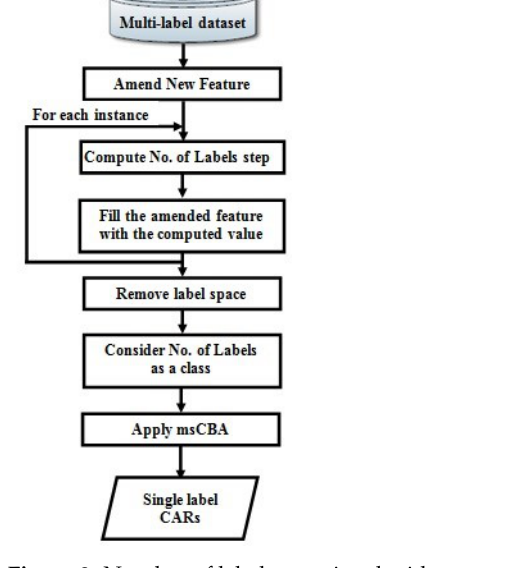
Figure 3. Number of labels associated with a stage of instance learning. Algorithm 2 ML-CBA